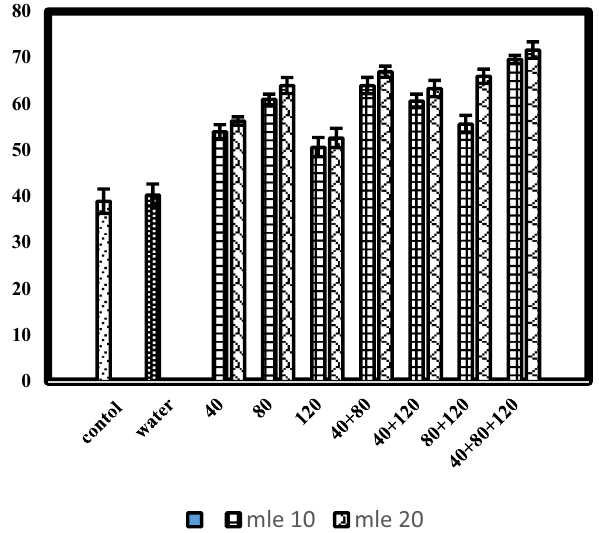
Figure 1. Number of branches plant −1 of black cumin as affected by moringa leaf extract applied at various growth